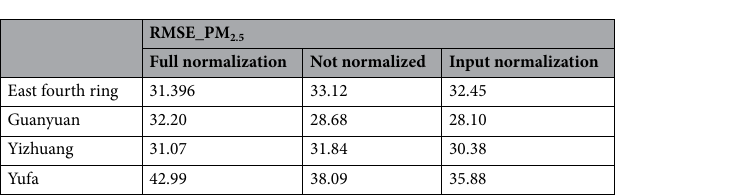
Table 7. Comparison of prediction results of three pollutant parameters in LightGBM model for all